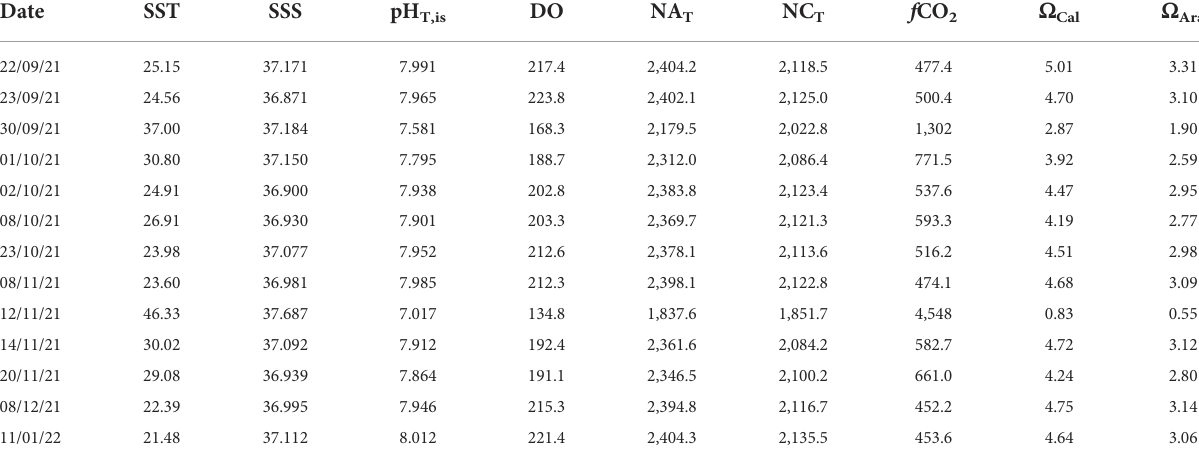
TABLE 1 Summary of visits to the coastal areas affected by the lava during the La Palma 2021